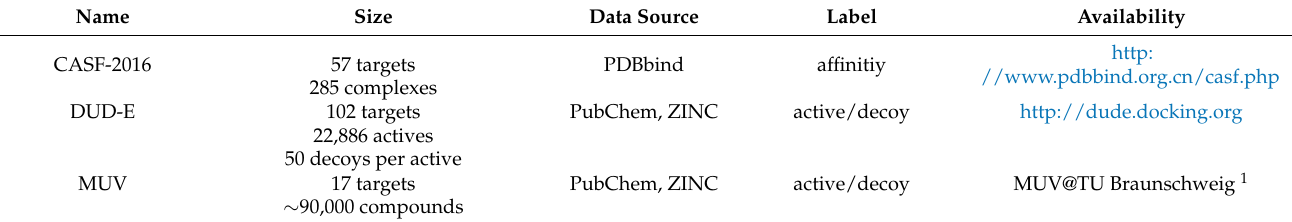
Table 2. Benchmark data sets. Evaluating novel models on labeled benchmark data is crucial for any machine learning task, including deep learning-based virtual screening. The table depicts some commonly used databases with their respective size, the origin of the data, provided information (affinity or activity) as well as their availability through websites (accessed on 18 March